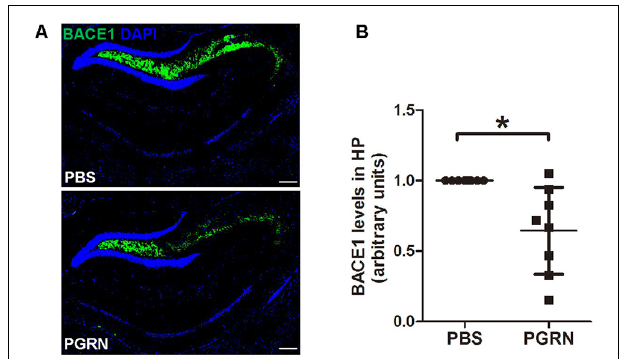
FIGURE 2 | PGRN administration reduces β -secretase (BACE1) levels in the hippocampus of 5xFAD mice. (A) Representative images of BACE1 of the hippocampus of 5xFAD mice injected with PBS (control) or PGRN. BACE1 (green) and DAPI (blue). Scale bars, 200 µ m. (B) Quantification of BACE1 immunostaining in the hippocampus, all values were normalized to left hemisphere levels for each mouse, n = 8, * p < 0.05, paired student’s t